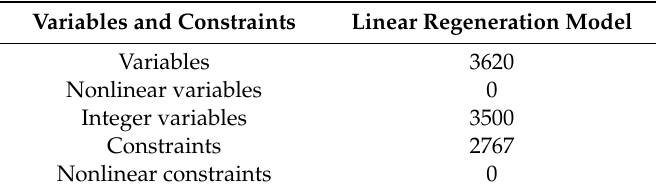
Table 1. Total number of variables and constraints used in the models.